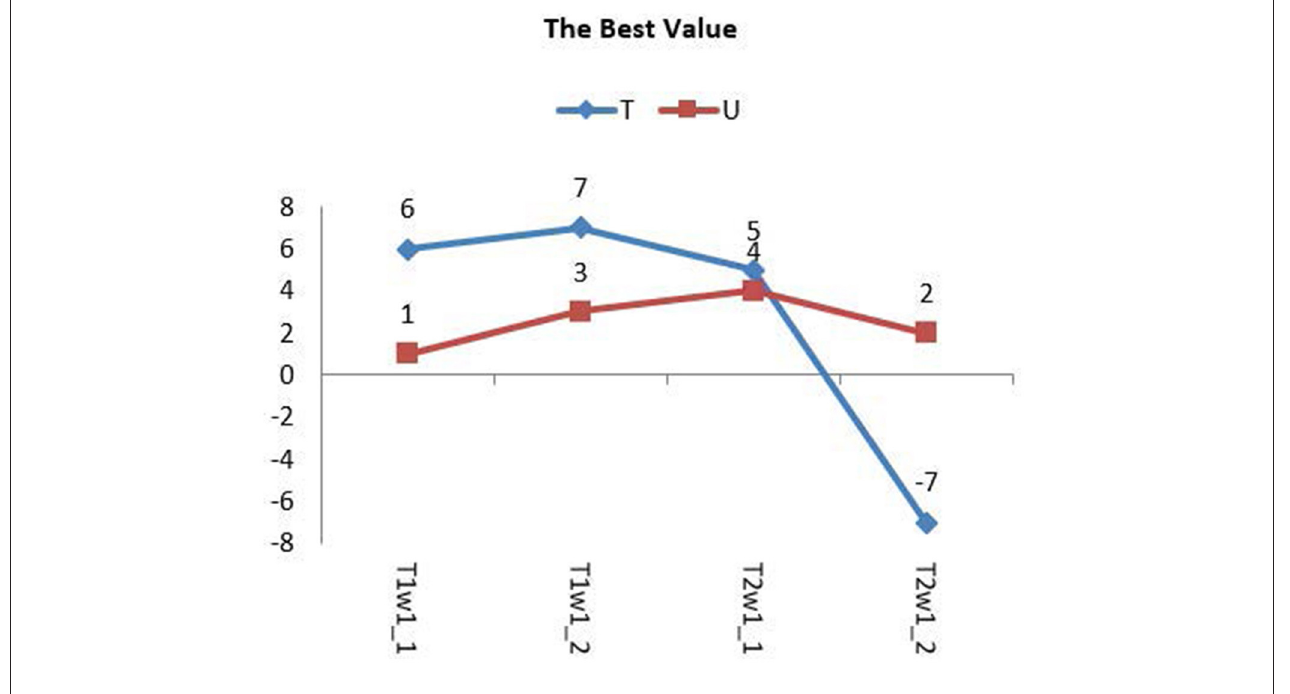
FIGURE 10 | The tendency of best values T and µ for group 1.